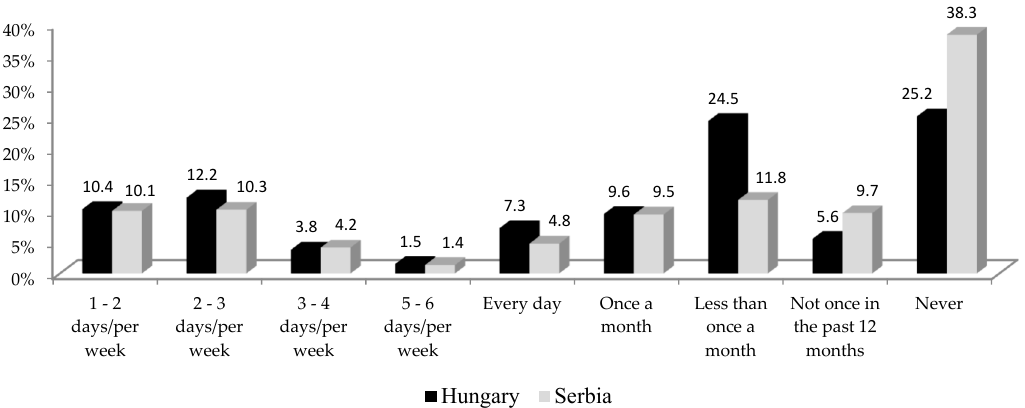
Figure 1. The prevalence of alcohol consumption among older adults in Serbia and Hungary.